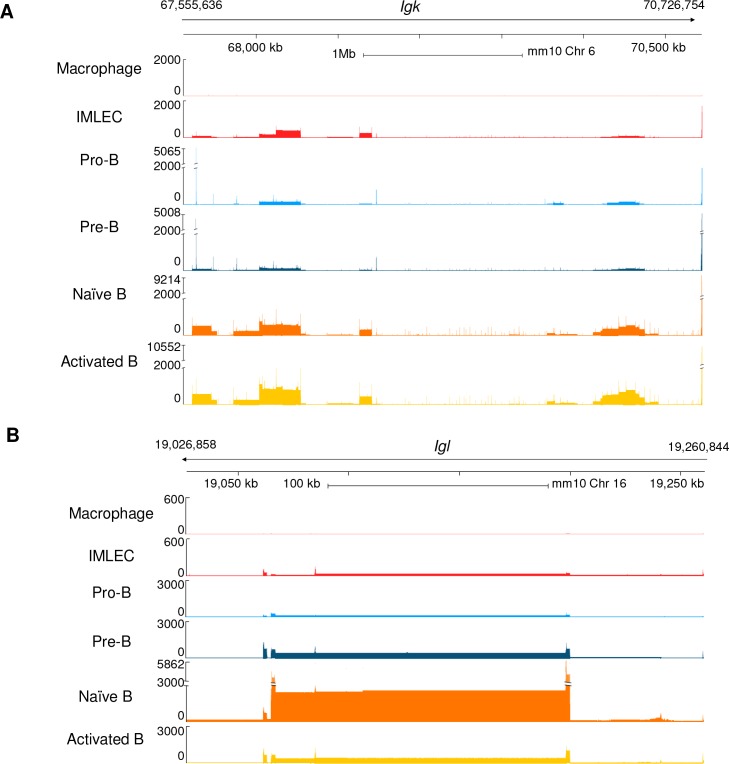
cKO IMLECs have a similar expression patterns as that of B-lymphoid subsets in the sterile transcripts from Igk and Igl loci.(A, B) Genome browser display of transcript expression of Igk locus in chromosome 6 (A) and Igl locus in chromosome 16 (B). For each track, the y-axis is the normalized number of aligned reads counts of gene region, whereas the x-axis depicts physical distance in base-pairs (bp). Numbers on top indicate the start and end positions of specified gene regions.